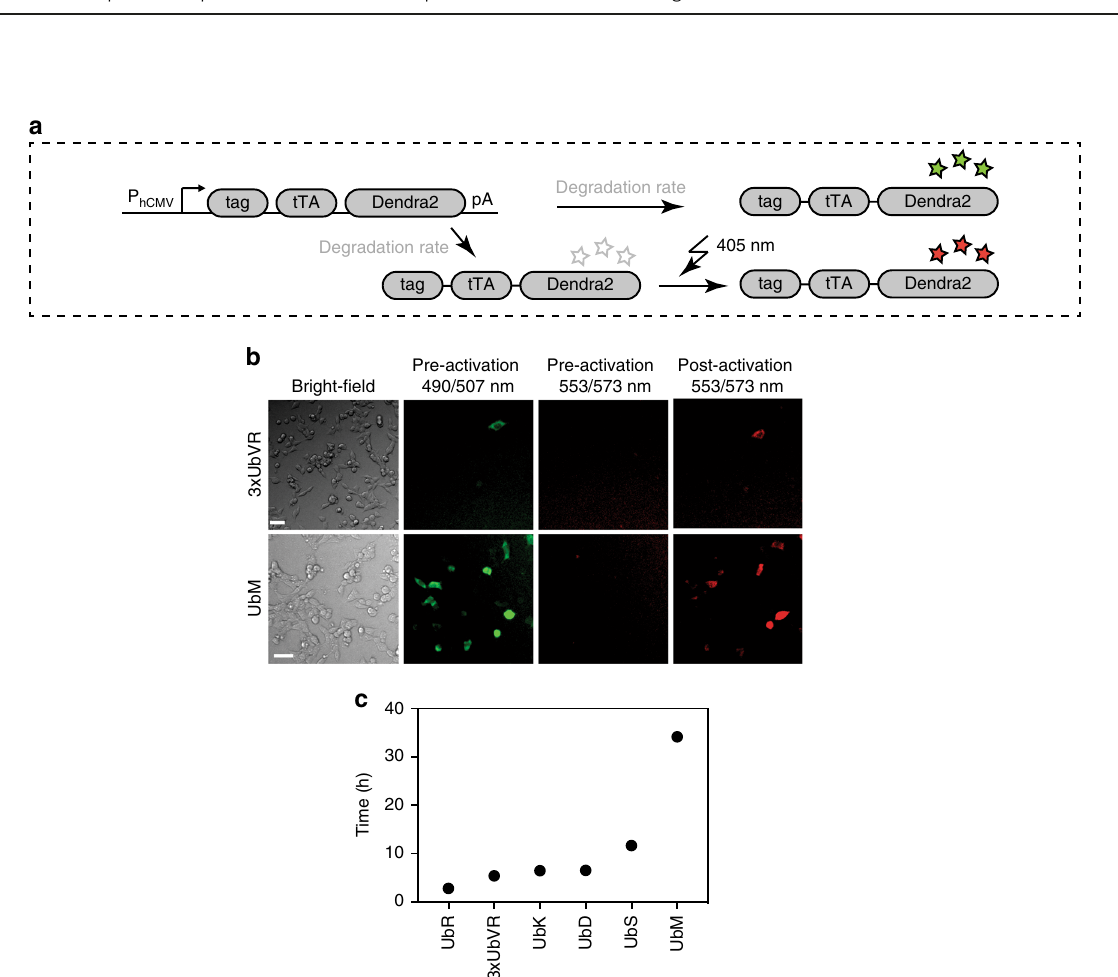
Fig. 2 Tunability of the dose – response curves with six selected protein tags. a Schematic of the six selected tags (3xUbVR, UbR, UbK, UbD, UbS, UbM) fused to tTA-Dendra2 and exposed to increasing concentrations of doxycycline (dox). b HEK-293 cells (3 × 10 4 ) were transfected with the different constructs (P hCMV -tag- tTA - Dendra2 -pA) and the reporter gene (P TRE - SEAP -pA). SEAP levels in the culture supernatant were pro fi led after 24 h. c Schematic of the six selected tags (3xUbVR, UbR, UbK, UbD, UbS, UbM) fused to rtTA-Dendra2 and exposed to increasing concentrations of dox. d HEK- 293 cells (3 × 10 4 ) were transfected with the different constructs (P hCMV -tag- rtTA - Dendra2 -pA) and the reporter gene (P TRE - SEAP -pA). SEAP levels in the culture supernatant were pro fi led after 24 h. e Schematic of the six selected tags (3xUbVR, UbR, UbK, UbD, UbS, UbM) fused to the autoactivating P TRE - tag- tTA - Dendra2 -pA construct and exposed to increasing concentrations of dox. f HEK-293 cells (3 × 10 4 ) were transfected with the different constructs (P TRE -tag- tTA - Dendra2 -pA) and the reporter gene (P TRE - SEAP -pA). SEAP levels in the culture supernatant were pro fi led after 24 h. The data represent the